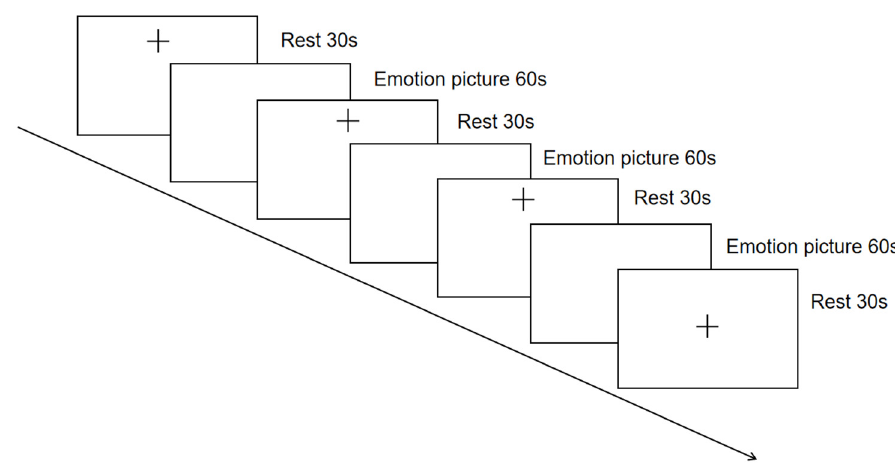
Figure 1. Emotional autobiographical memory task design.